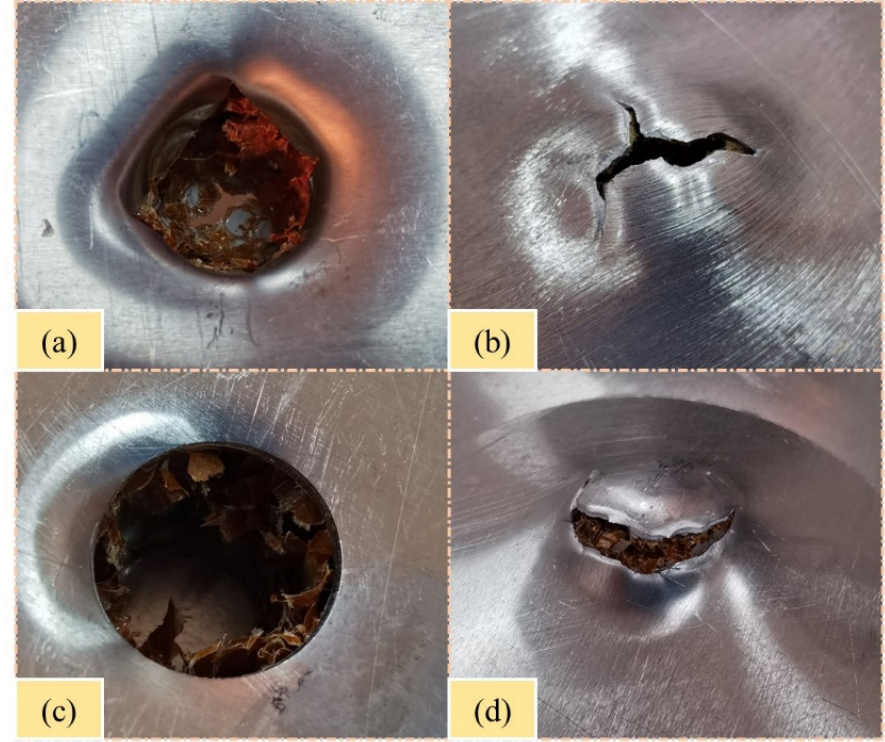
Figure 19. Damage morphology of H. ( a ) Front plate of H-H-100J. ( b ) Back plate of H-H-100J. ( c ) Front plate of F-H-100J. ( d ) Back plate of F-H-100J.